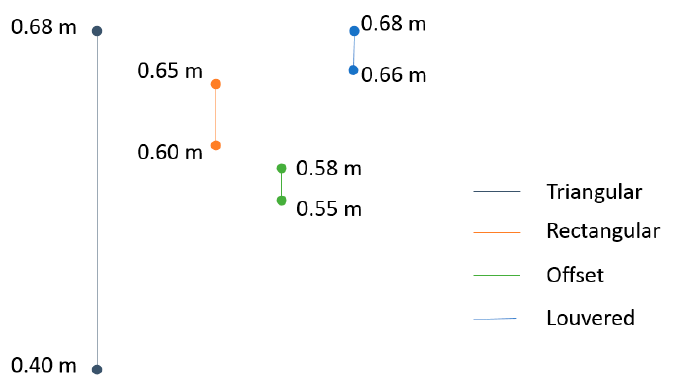
Figure 6. Allowable heat exchanger width using different fin types.